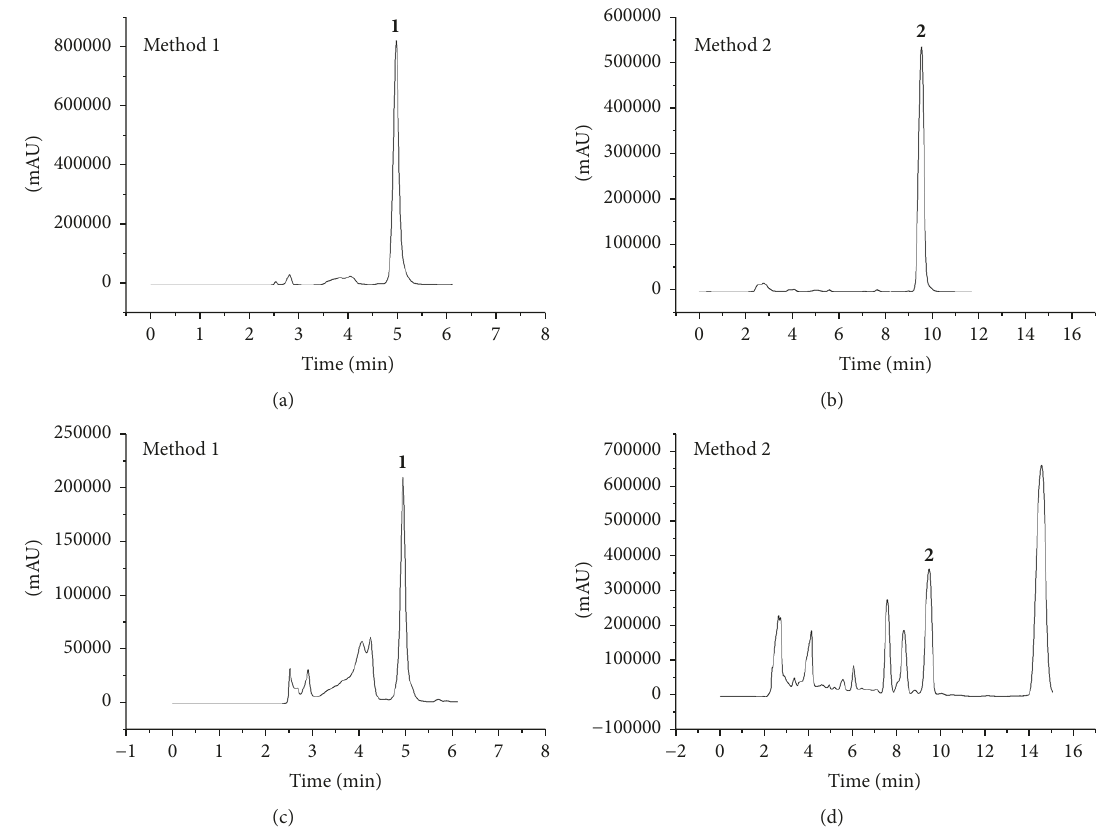
Figure 2: HPLC chromatograms (254 nm) of standard compounds 1 (a) and 2 (b) and the ethanol extract of P. grandis (c and d).